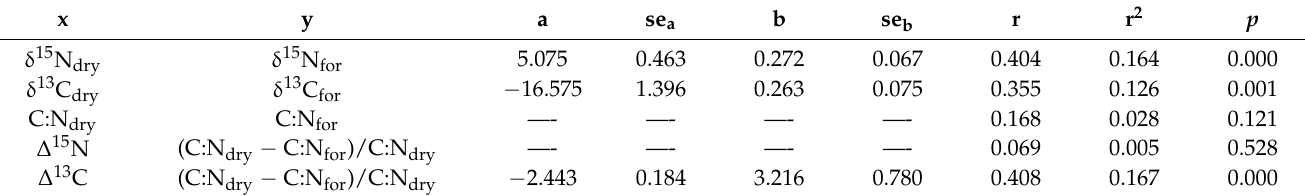
Table 1 . Parameters of the different regression models relating values measured in dry and forma- lin-preserved aliquots of zooplankton samples. The subindex dry or for indicates if dry or formalin- preserved aliquots were used, respectively. ∆ 15 N = δ 15 N for − δ 15 N dry ; ∆ 13 C = δ 13 C for − δ 13 C dry . Regressions are of the form: y = a + b · x; x: independent variable; y: dependent variable; a: constant, b: slope; r: correlation; r 2 : coefficient of determination; p : significance value; se a , se b : standard error of the a or b estimates, respectively. The number of data pairs was n = 87 for all